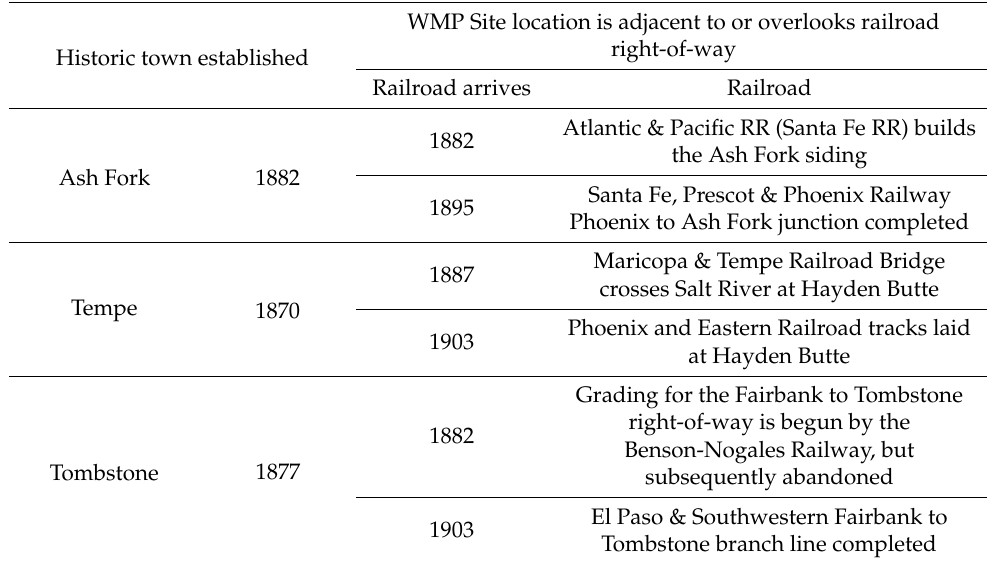
Table 2. WMP Historic context: Townships and railroad